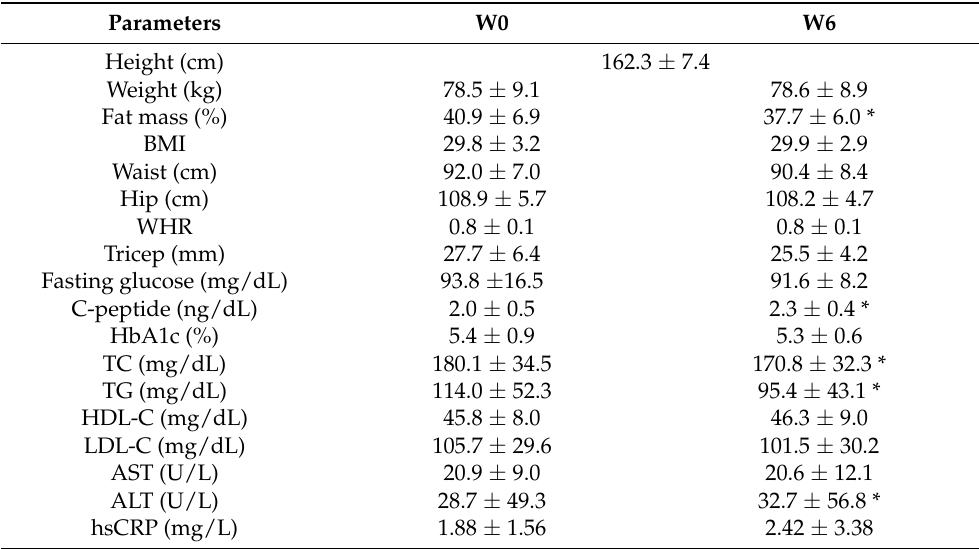
Table 1. Anthropometric, blood lipid, and inflammatory parameters for all participants ( n = 21) at baseline and the end of the study.